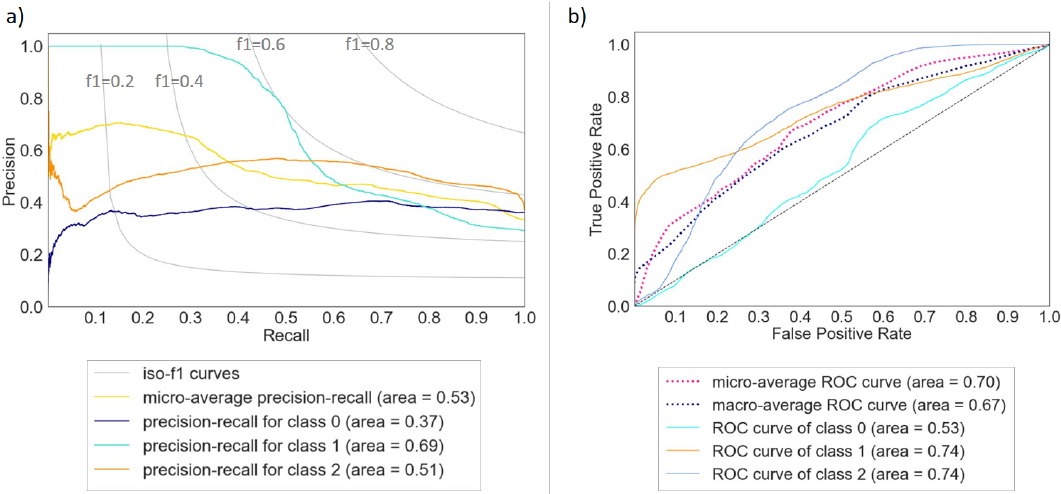
Figure 6. Logistic regression simulation results: ( a ) precision–recall curve; ( b ) ROC